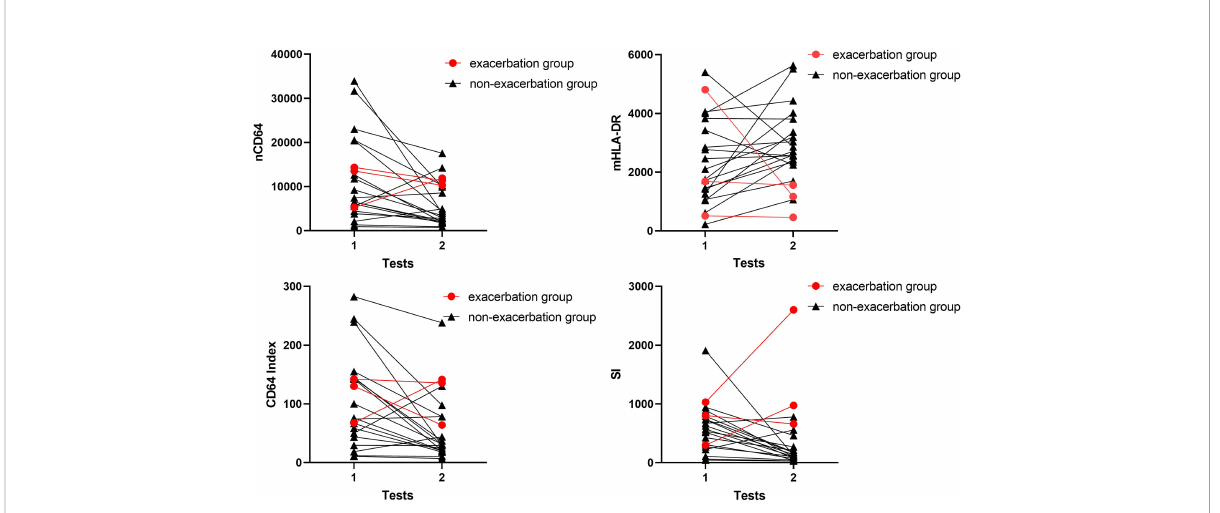
FIGURE 9 Longitudinal results of the immune monitoring panels in infection KTRs. The changes of MESFs of nCD64 and mHLA-DR, CD64 index and SI were shown for each patient. The exacerbation group was de fi ned as D SOFA > 0 and the non-exacerbation group was de fi ned as D SOFA ≤ 0.